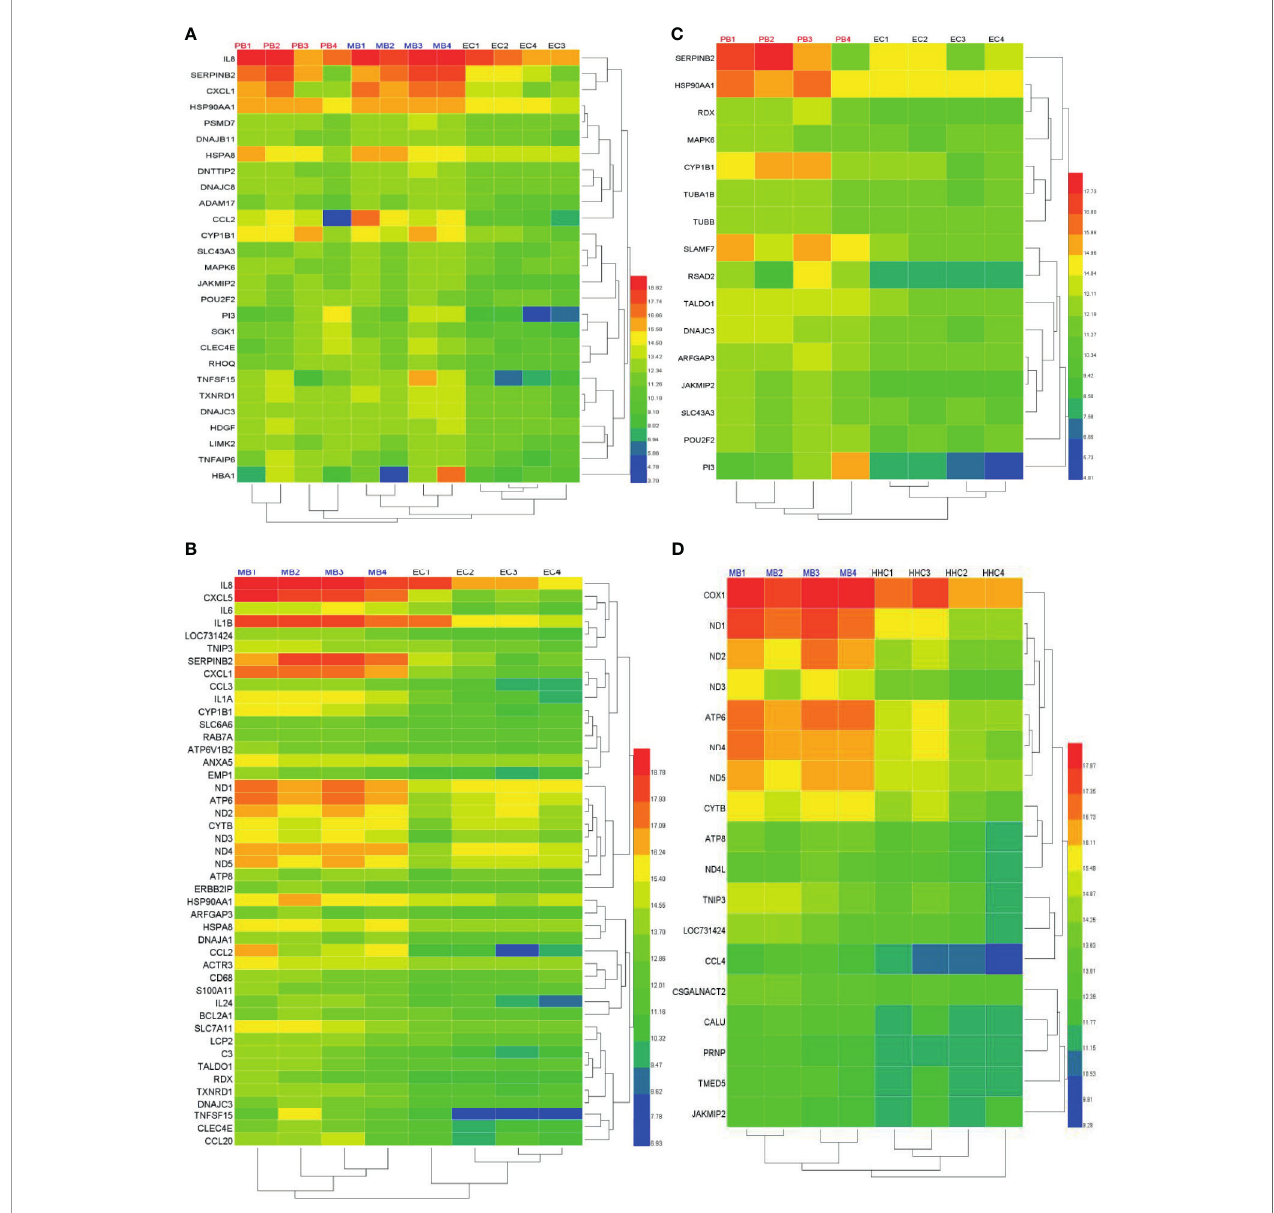
FIGURE 4 | Heat map of differentially expressed genes (DEGs) in leprosy patients compared to non-leprosy controls. (A) The top 27 DEGs upregulated in leprosy patients (MB, n = 4; PB, n = 4) compared to ECs (n = 4). (B) The top 45 DEGs upregulated in MB leprosy patients (n = 4) compared to ECs (n = 4). (C) The top 16 DEGs upregulated in PB leprosy patients (n = 4) compared to ECs (n = 4). (D) The top 18 DEGs were upregulated in MB leprosy patients (n = 4) compared to HHCs (n = 4). Selection criteria were p < 0.05 and fold change ≥ 2. MB, multibacillary; PB, paucibacillary; HHCs, healthy house contacts; ECs, endemic